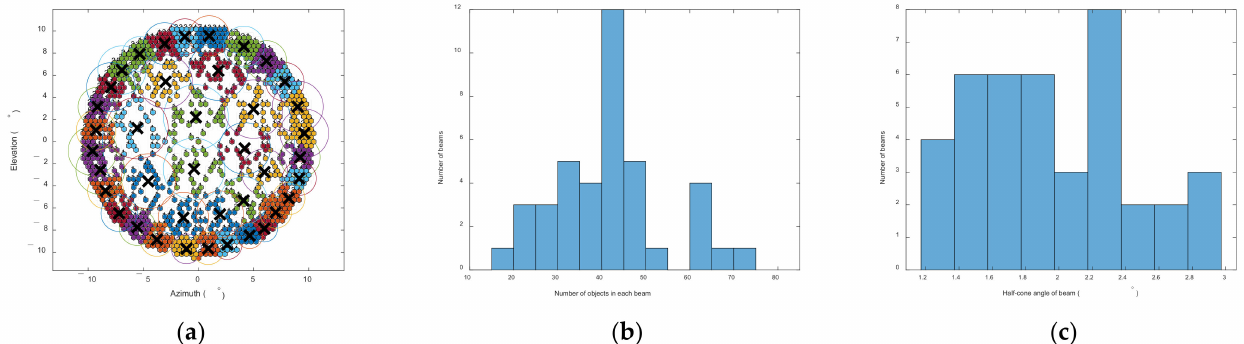
Figure 9. Optimization results of the beam allocation based on the modified K-means clustering when parameter α equals 0.5 and β equals 0.2: ( a ) Plot of the allocated 40 beams. The crossing indicates the geometrical center of each beam. The neighboring hexagonal cells in the same beam are marked with the same color; ( b ) Statistics of the beam occupation; ( c ) Statistics of the beam